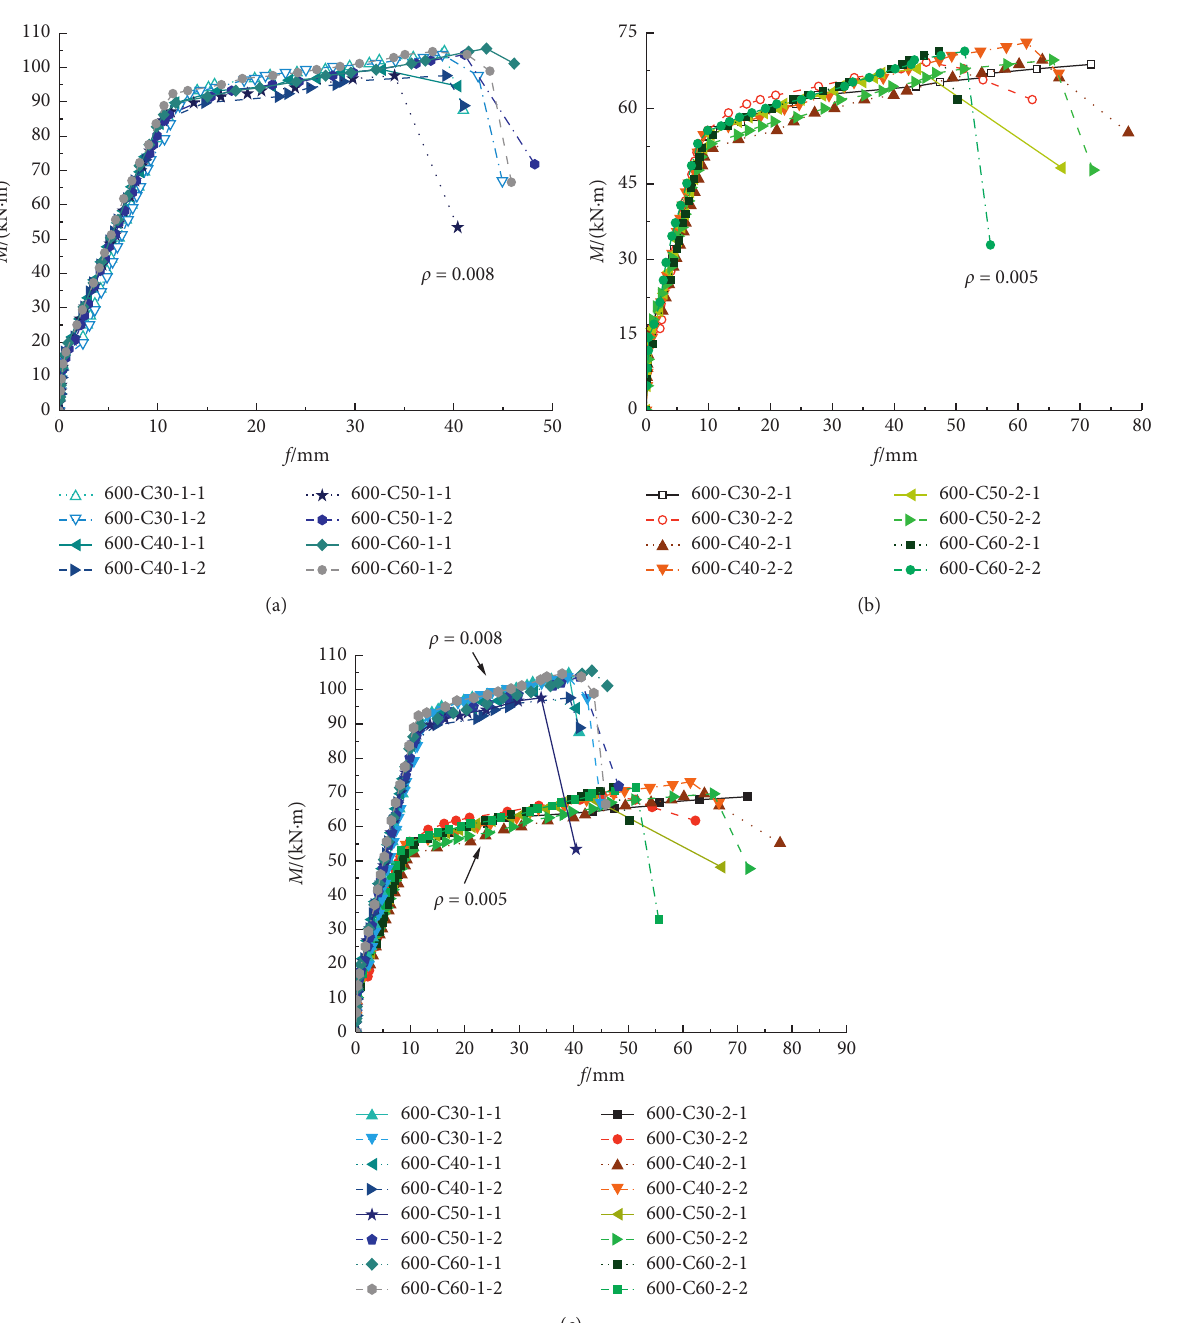
Figure 5: The load-deformation curves for RC